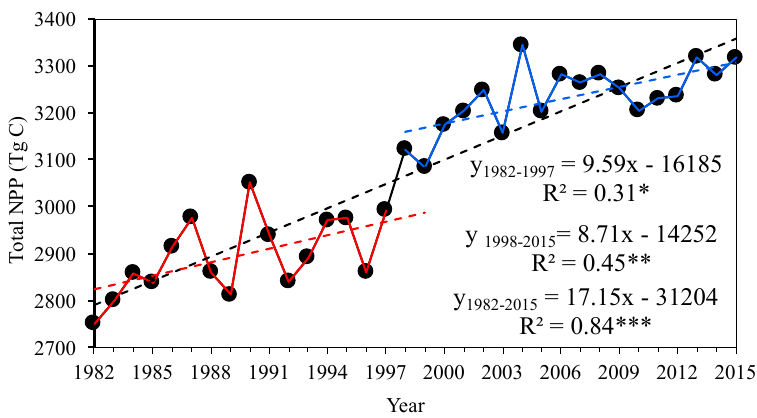
Figure 3. Trend of annual total net primary productivity (NPP) in China from 1982 to 2015. The mark (***) indicates relative levels of significance with p < 0.001, the mark (**) indicates relative levels of significance with p < 0.01, and the mark (*) indicates relative levels of significance with p < 0.05.